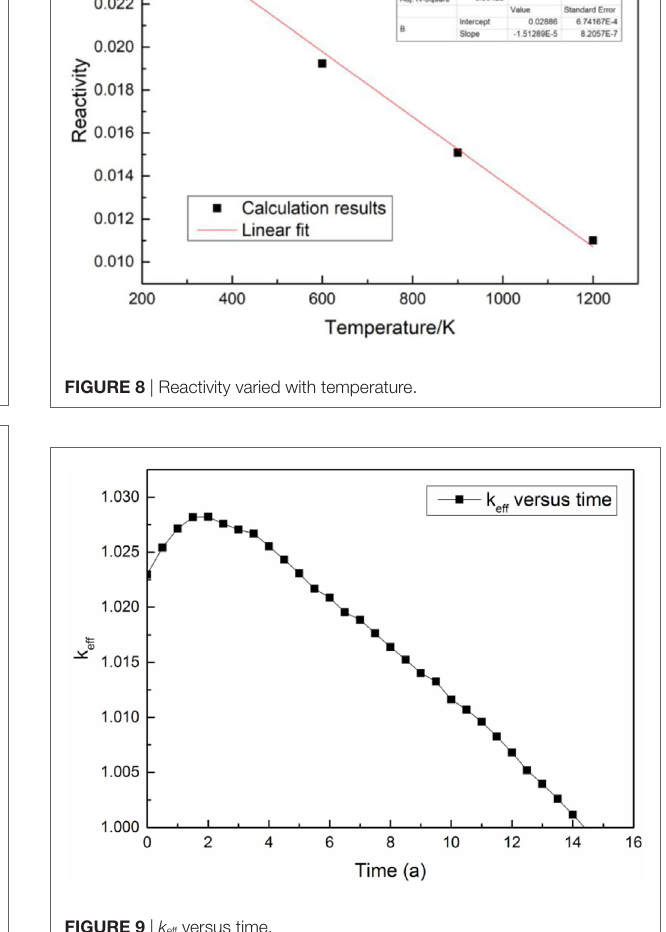
FigUre 7 | Radial normalized power distribution.